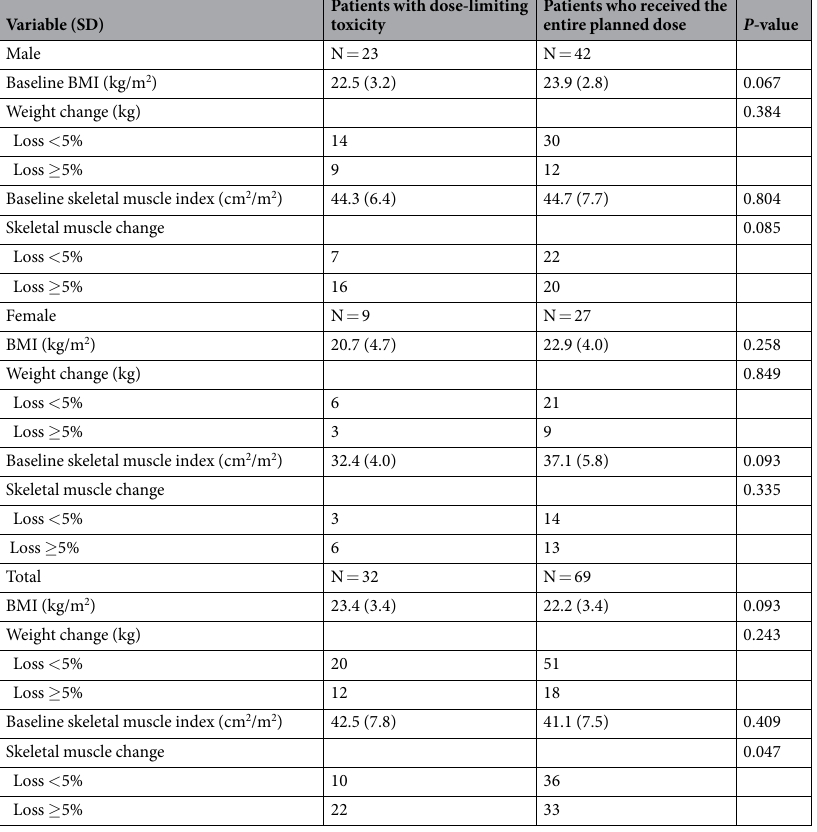
Table 5. Comparison of anthropometric parameters and body composition in function of dose-limiting toxicity. Abbreviation: BMI: body mass